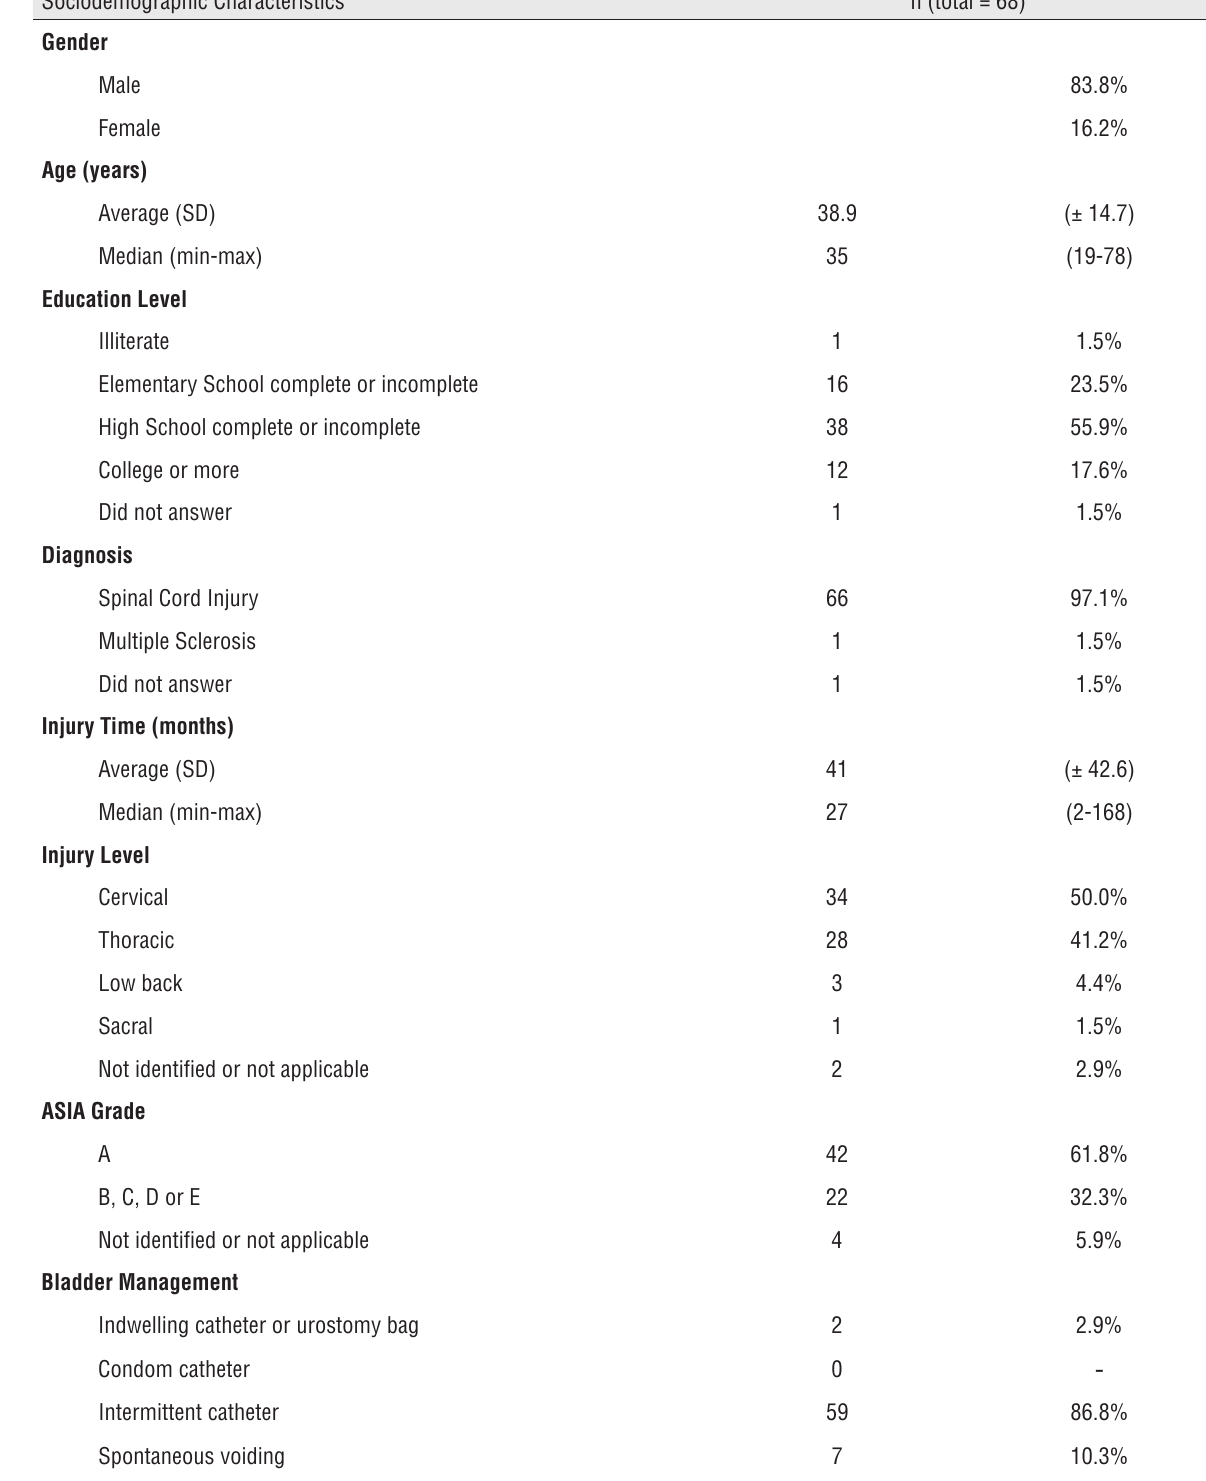
Table 1 - Sociodemographic and clinical characteristics of 68 patients with neurogenic lower urinary tract disfunction. Sociodemographic